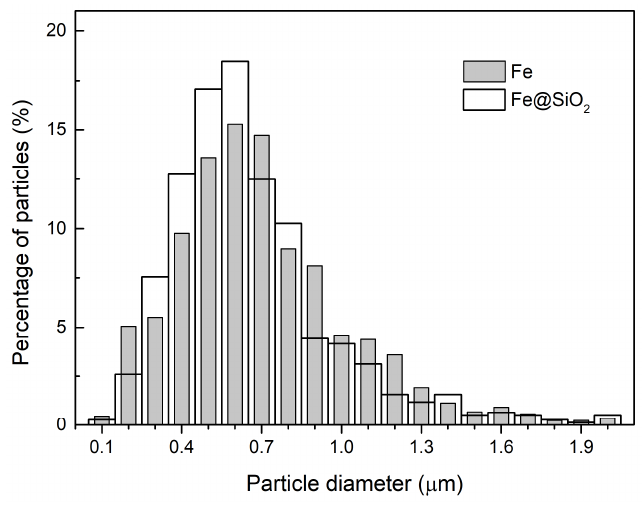
Figure 4. Particle size distribution measured from the SEM images of the “Fe” and “Fe@SiO 2 ” powders.